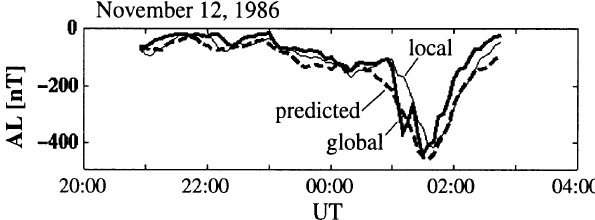
Fig. 9. An example on predicting the A ‚ index. The predicted curve has been obtained from the local A ‚ indices by linear filtering